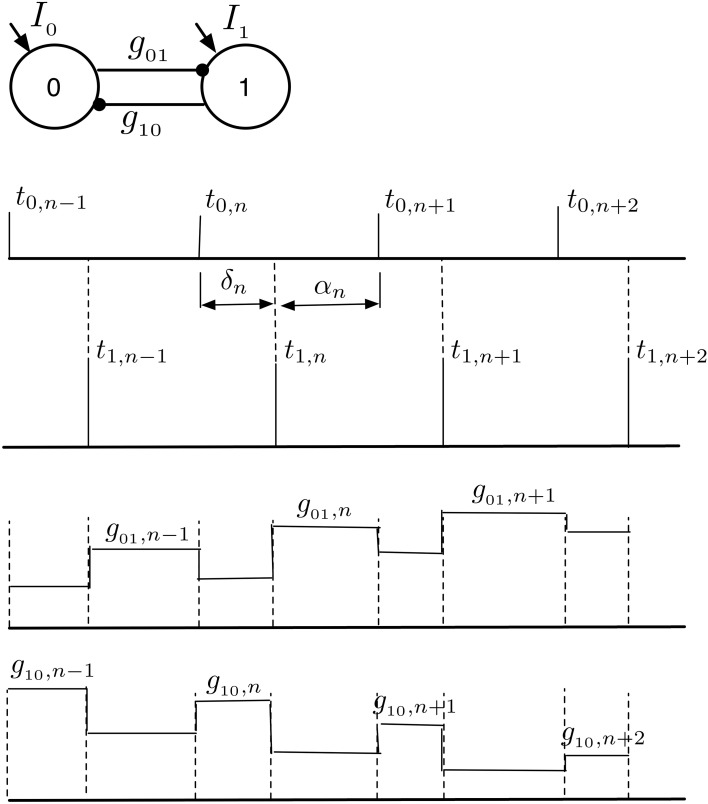
1:1 Phase locked synchrony in a 2-MCI network. This figure illustrates the evolution of consecutive spike times {δ, α} during phase locked 1:1 synchronization. The corresponding changes in {g01, g10} due to the STDP rule are also shown. We use this concept of 1:1 phase locked spike-time and STDP evolution to derive the map defined in Equation (15).